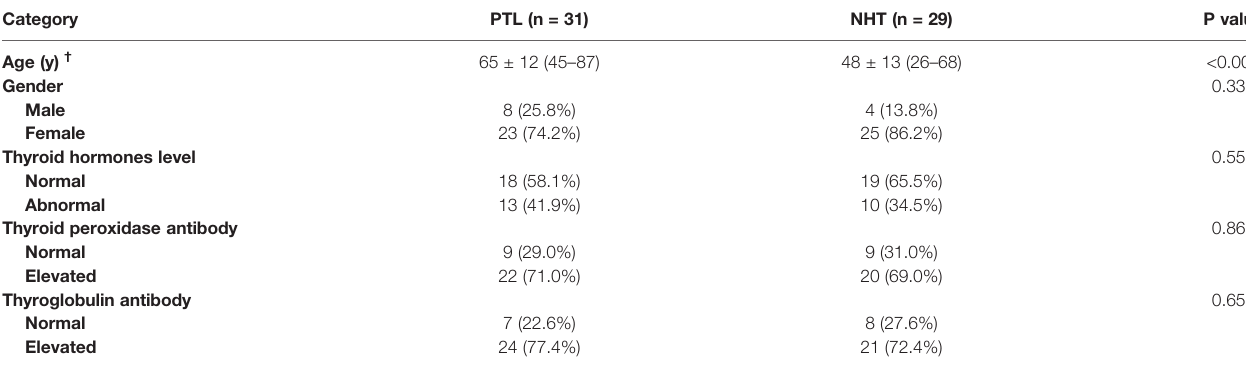
PTL, primary thyroid lymphoma; NHT, nodular Hashimoto ’ s thyroiditis. Unless otherwise indicated, data are numbers of patients, with counted percentage in parentheses. † Data are as mean ± standard deviation, with ranges in